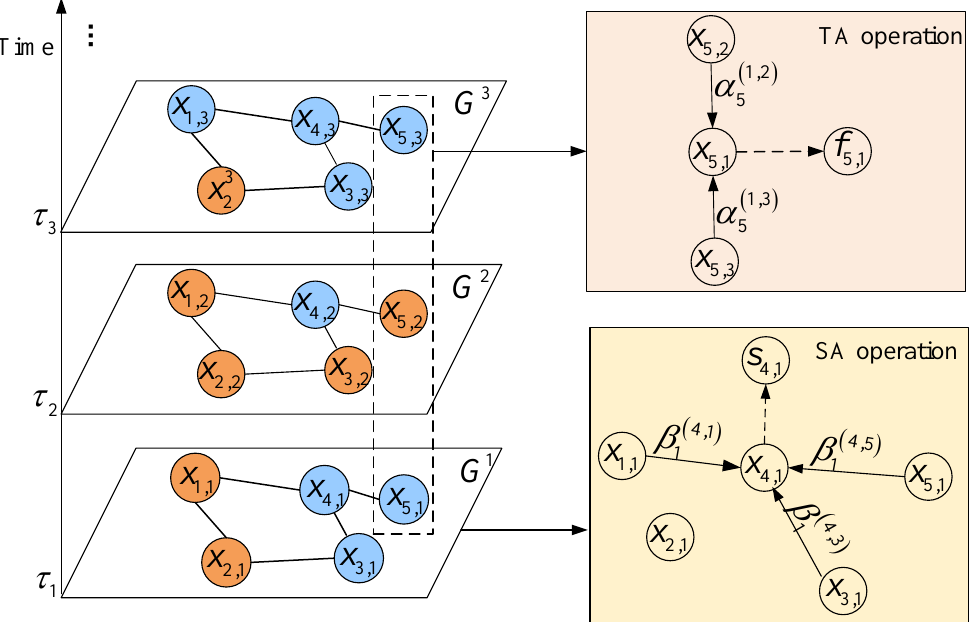
Figure 7. Diagram of STA for temporal attention operation and spatial attention